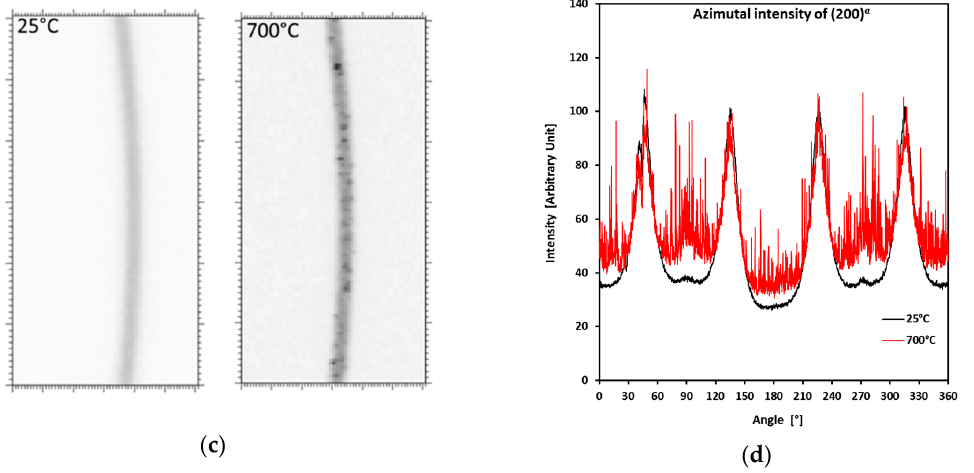
Figure 2. ( a ) and ( b ) full diffraction patterns obtained at 25 °C and 700 °C, respectively, during the heating sequence (the intensities are given as an arbitrary unit). The clear shadow in the center corresponds to the beam stop. Black rectangles correspond to the fields of the magnified views in Figure c. ( c ) Magnifications of the (200) DS ring of ferrite at 25 °C and 700 °C, respectively, during the heating sequence. The recrystallization peaks correspond to the individual dark spots seen at 700 °C on DS rings. ( d ) Intensities of the (200) Debye-Scherrer rings as a function of the azimuthal angle at 25 °C (black curve) and 700 °C (red curve).